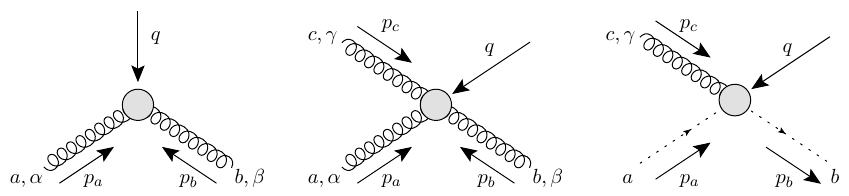
Figure 1 . Gluon two-point, gluon three-point, and ghost-gluon three-point functions with momen- tum insertion into the operator.